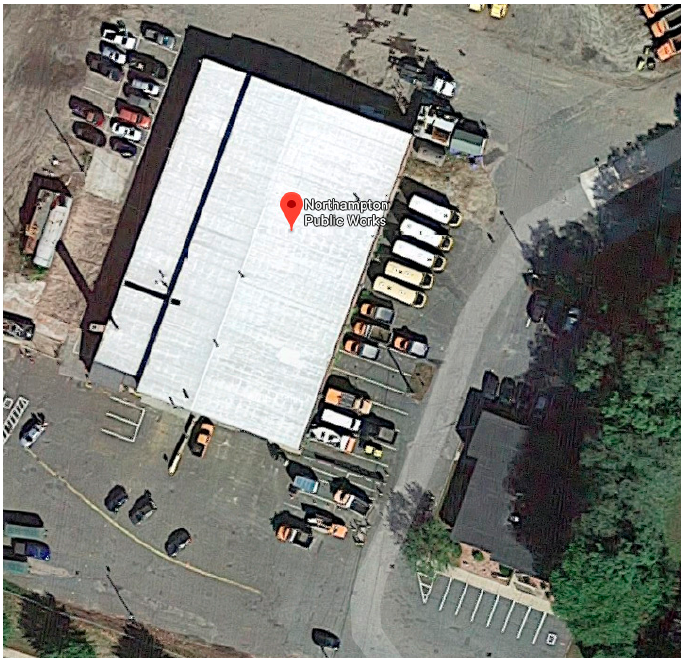
Figure 5. Satellite image from Google Earth shows location of Northampton DPW buildings (garage on top and administrative building on bottom). Map data: Apache License, Version 2.0, Google, 2020 [14,18].